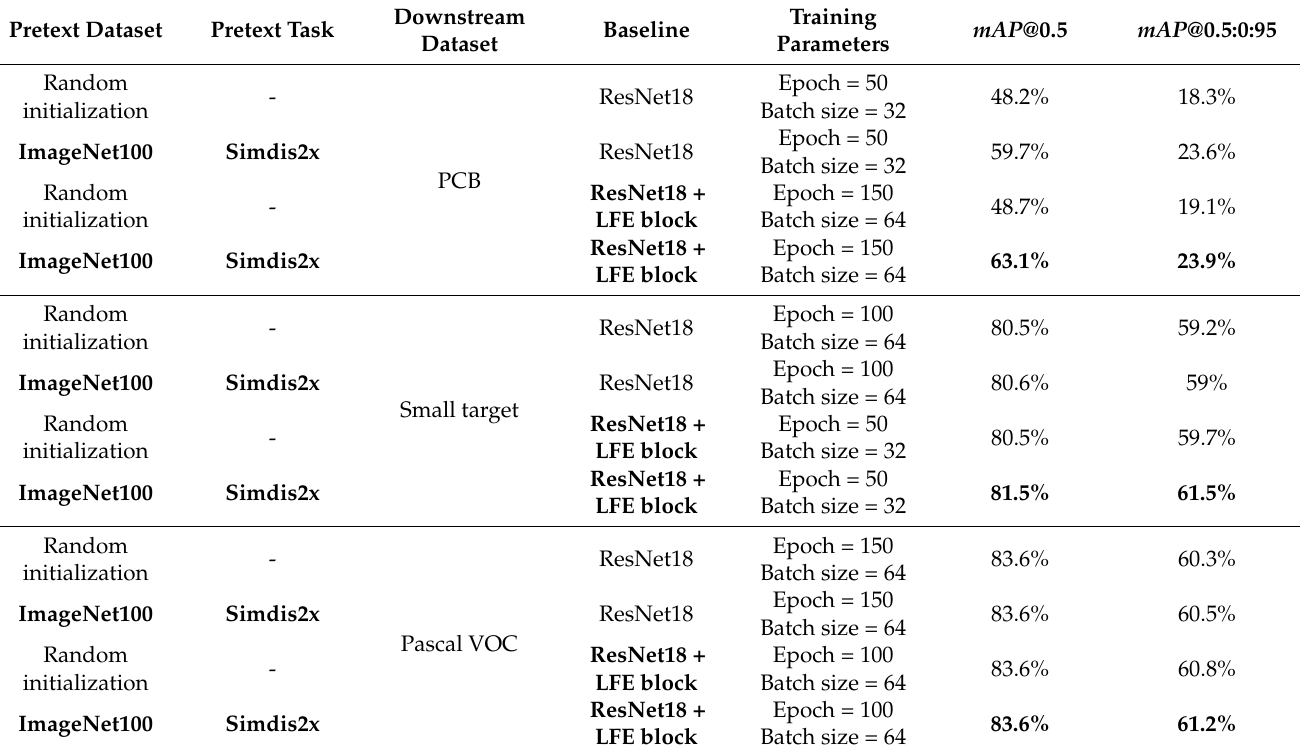
Table 3. Joint experimental results of improved self-distillation pre-training and location feature extraction structure.